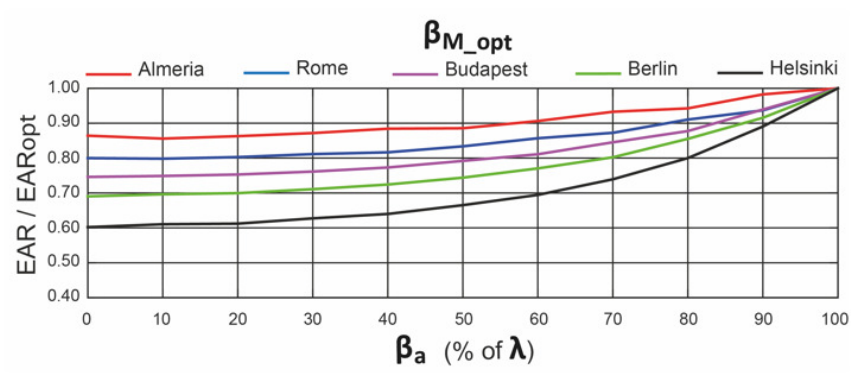
Figure 12. Influence of β a .